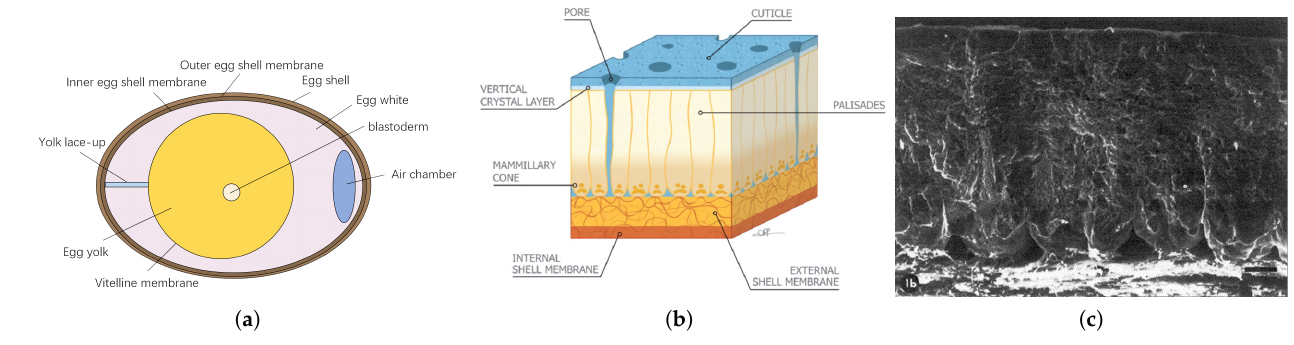
Figure 1. Schematic diagram of egg and eggshell structure. ( a ) Structure of the egg. ( b ) Microstructure of the eggshell. ( c ) Radial cross section of the